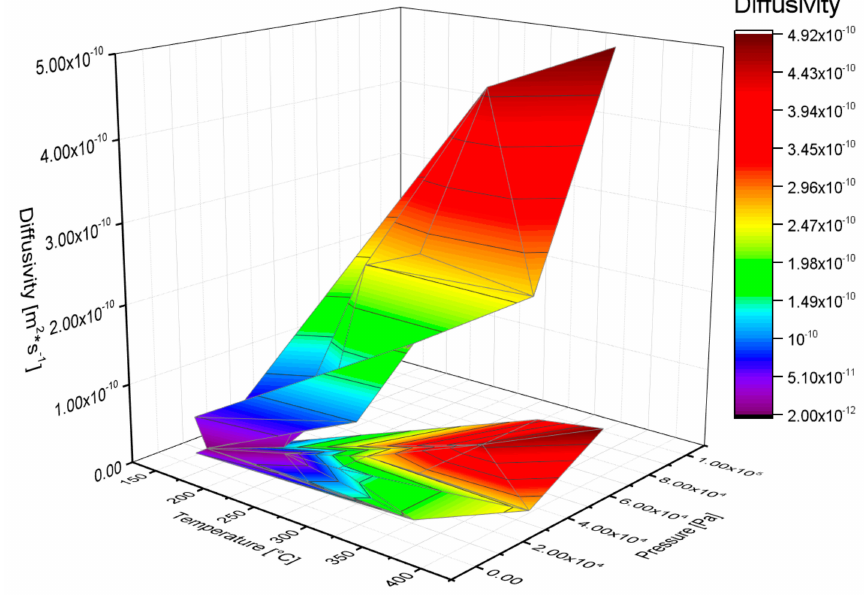
Figure 5. Di ff usion coe ffi cient evaluated by the numerical code as a function of the temperature of the specimen and of the initial